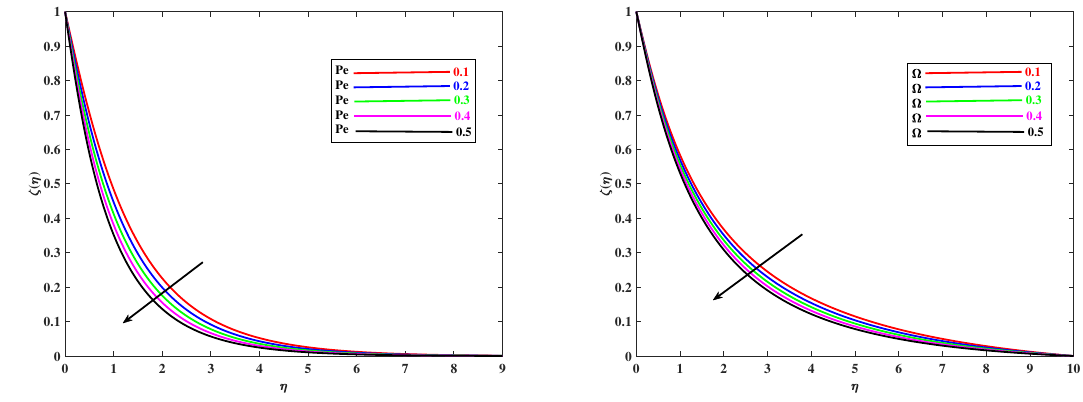
Figure 10. Effect of Pe and Ω to influence the biconvection